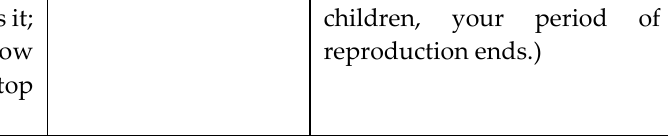
Table 3: Responses from three sites a in the state of Campeche, Mexico, to the question, “What is menopause?” ( ¿Qué es la menopausia? ). These are responses having to do with the end of